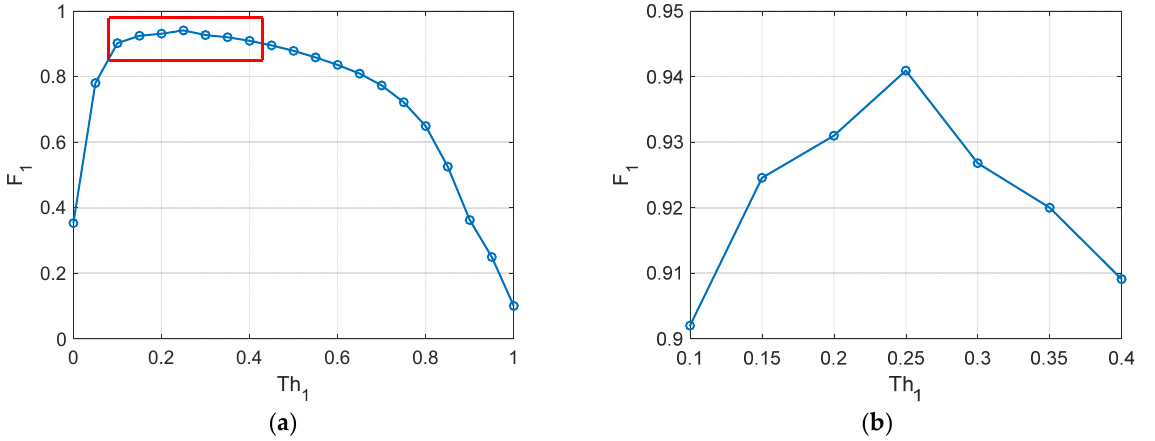
Figure 4. ( a ) The value of F 1 for each Th 1 with the step of 0.05 from 0 to 1. ( b ) The specific picture in the red box from ( a ).